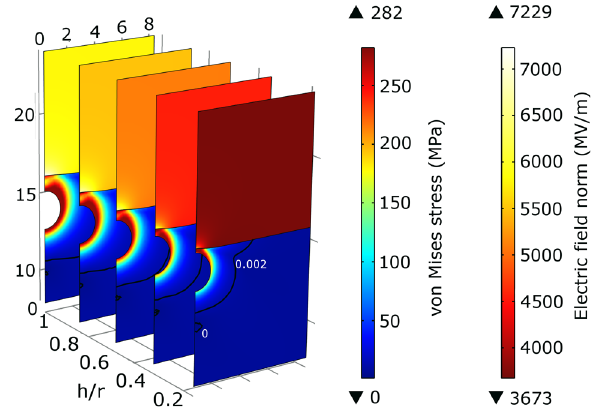
FIG. 5. A protrusion in the annealed copper above the voids placed at different depths under the surface. The radius of the voids is the same, thus the aspect ratio changes by changing the depth from 1 to 0.2 with the increment 0.2. The location of the maximum von Mises stress is shifting from the sides of the void towards the top of the void while decreasing the aspect